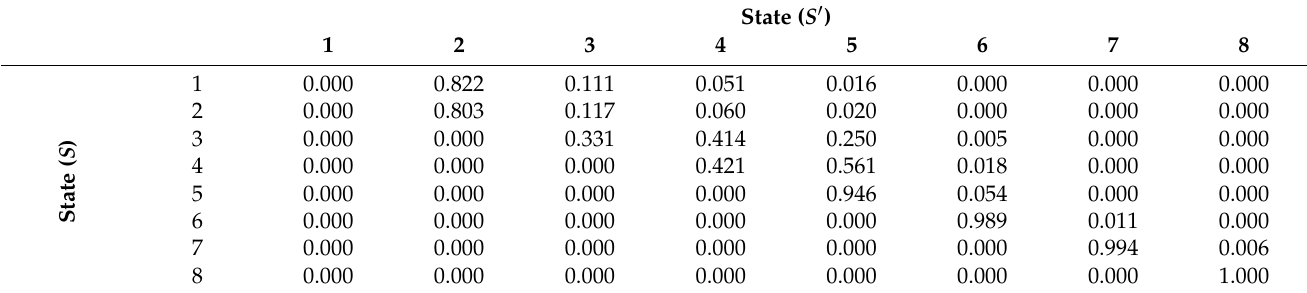
Table 2. Transition matrix using a pure birth Markov process and n-step transition do-nothing (modified from the source: Heidarydashtarjandi, Prasad-Rao, and Groth [6]). State ( S (cid:48)